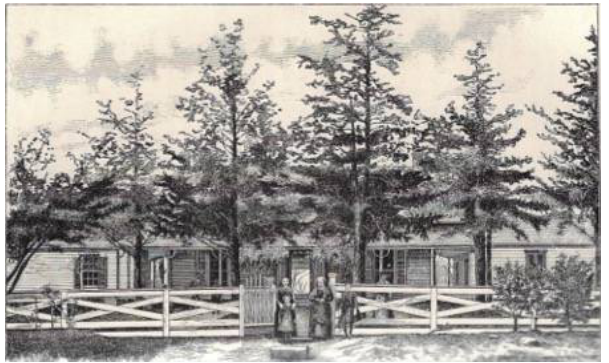
Figure 3. Bishop George Foster Pierce’s home at his cotton plantation, Sunshine, just outside of Sparta in Hancock County, Georgia (Smith 1888, p. 270).